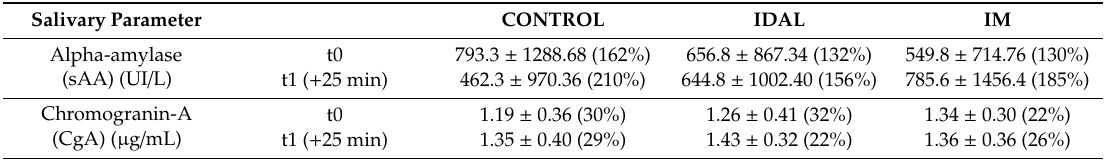
Table 6. Means, SD and coe ffi cient of variation (CV) of salivary alpha-amylase (sAA) and salivary Chromogranin-A (CgA) for the CONTROL, IDAL, and IM treatments just before vaccine injection (t0, baseline) and 25 min after vaccine injection ( + 25